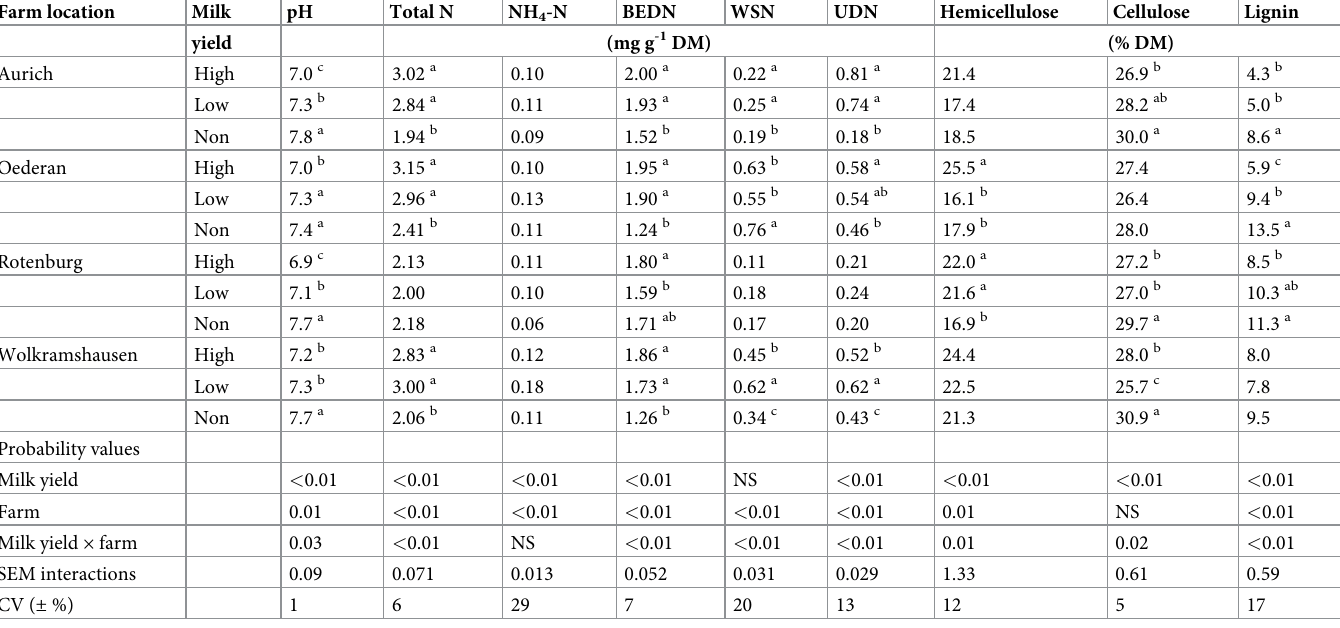
Table 2. Mean chemical composition of the cow faeces, broken down according to the four farms and the three milk yield groups; BEDN = bacterial and endogenous debris N; WSN = water soluble N; UDN = undigested dietary N. Farm location Milk